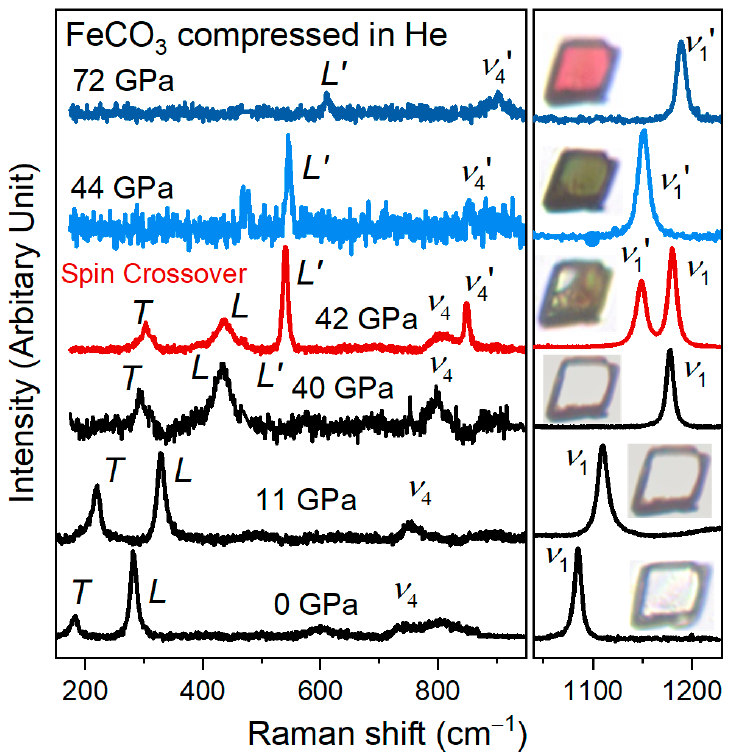
Figure 1. Representative Raman spectra of siderite FeCO 3 at high pressures. The Raman modes are labeled as T , L , ν 4 , and ν 1 based on Rividi et al. (2010) [36]. The T , L , and ν 4 modes were simultaneously enlarged to illustrate changes in Raman spectra of siderite. At 42 GPa, the splitting of L , ν 4 , and ν 1 modes into L (cid:48) , ν 4 (cid:48) , and ν 1 (cid:48) indicates the occurrence of spin transition of Fe 2 + in siderite. Insets, the color evolution of siderite sample captured through optical microscope images.